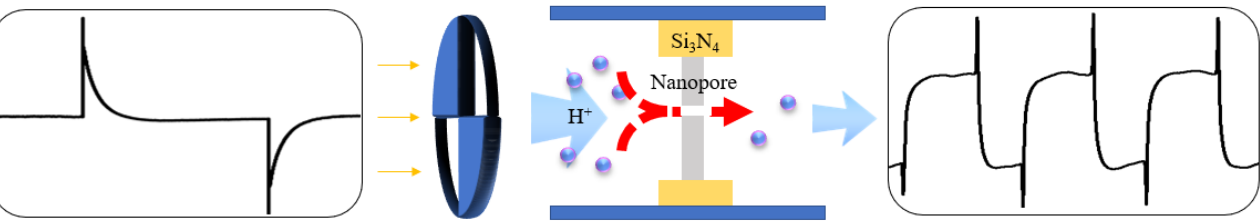
Figure 5. Schematic diagram of the mechanism underlying the photocurrent.